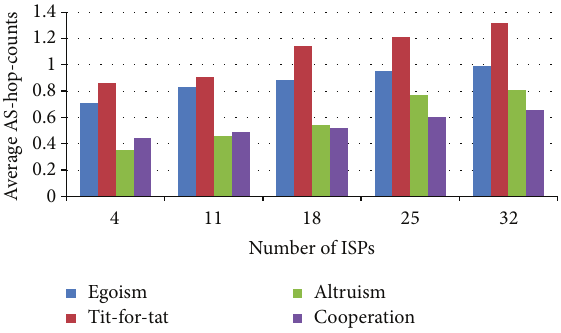
Figure 7: Content delivery cost versus ISP number.